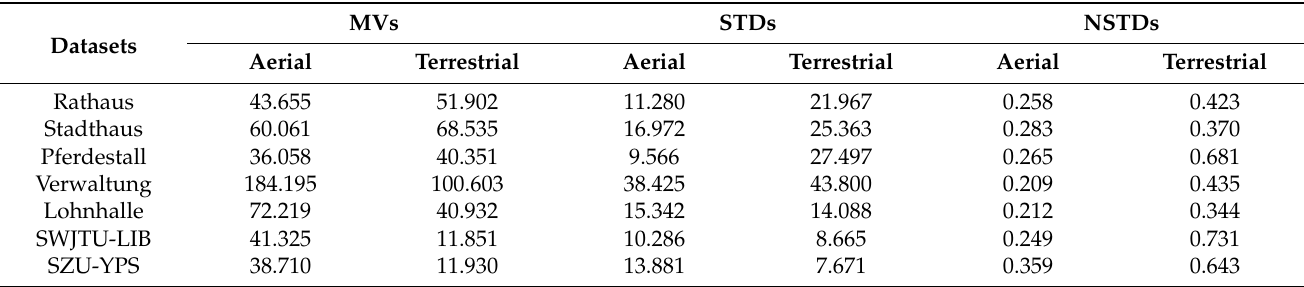
Figure 5. The rRMSEs of the four compared BA strategies used for the seven tested areas. Different colors indicate different BA methods; black: FA_FT; red: FA_RT; blue: RA_RT; green: RA_FT. Table 11. Mean values (MVs), standard deviations (STDs), and normalized standard deviations (NSTDs) of the number of points in equant